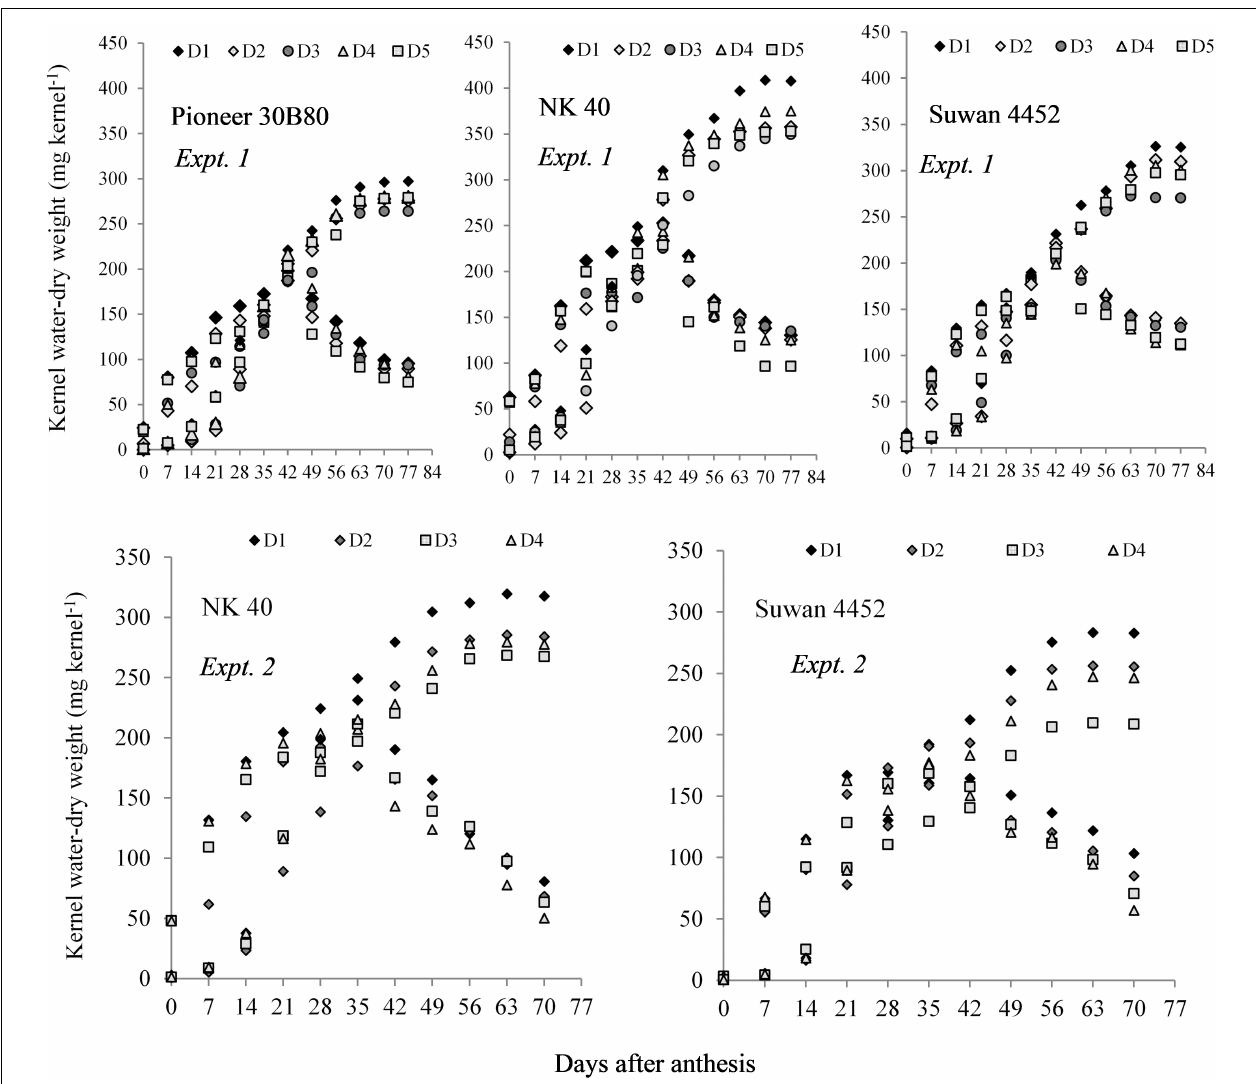
FIGURE 4 | Kernel water content and kernel dry weight of three hybrids (Pioneer 30B80, NK 40, and Suwan 4452) under five water regimes in Expt. 1 and two hybrids (NK 40 and Suwan 4452) under four water regimes in Expt. 2. For treatment details see Figure 3 legend.